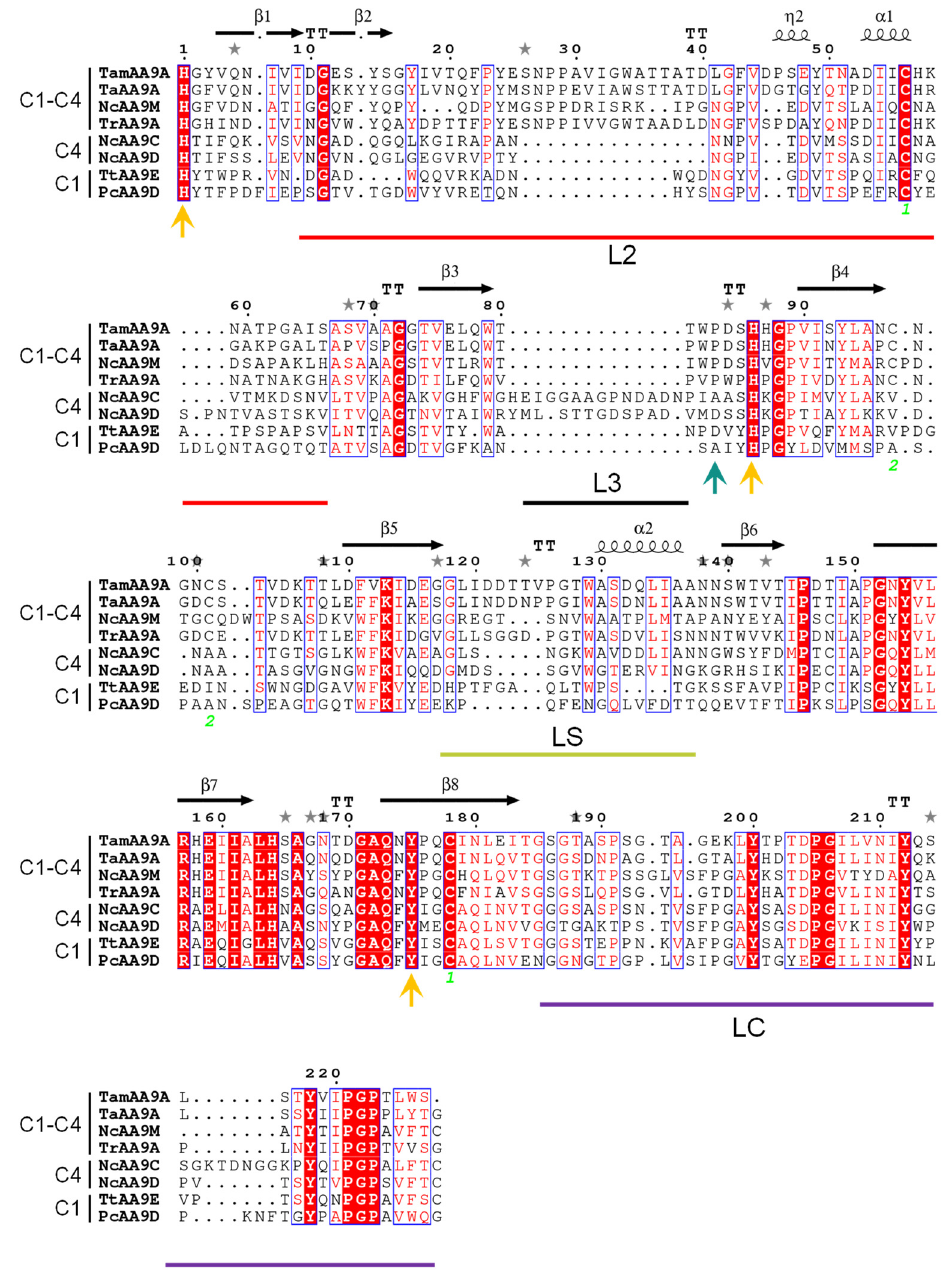
Figure 4. Sequence alignment of selected LPMOs. White in red background: fully conserved residues; blue frames: more than 70% of the residues aligned have similar properties (red residues on a white background). Yellow arrows indicate residues coordinating the catalytic copper. The green arrow shows the putative residue that controls regioselectivity in AA9s. Green numbers mark disulfide bonds. The loops interconnecting the strands of the β -sandwich are marked as L2, L3, LS and LC. Alignment was built with AA9 LPMOs from Thermoascus auranticus (TaAA9A), Neurospora crassa (NcAA9M, C and D), Trichoderma reesei (TrAA9A), Thermothielavioides terrestris (TtAA9E), and Phanerochaete chrysosporium (PcAA9D).